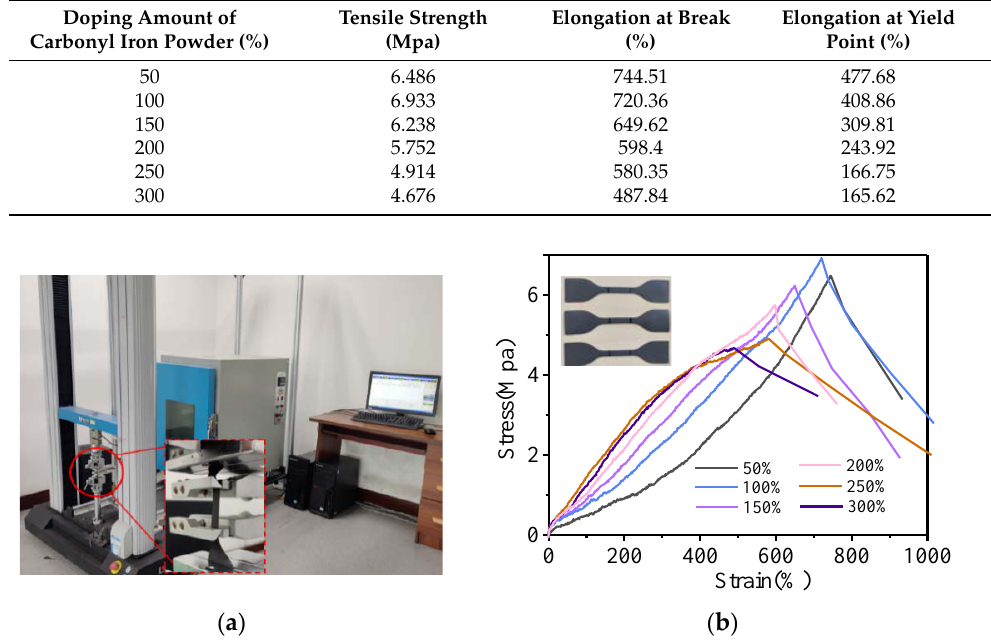
Figure 11. ( a ) A universal strength machine. ( b ) The stress-strain curve.